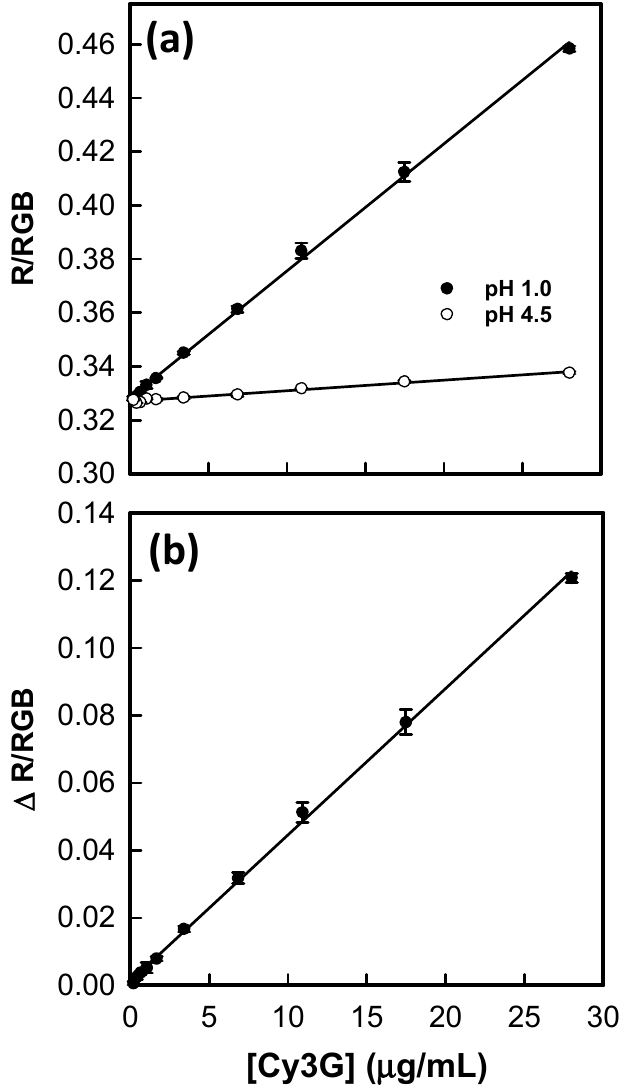
Figure 5. ( a ) R/RGB value at different concentrations of Cy3G at pH 1.0 (solid circles) and pH 4.5 (open circles). ( b ) ∆ (R/RGB) (difference between the values at pH 1.0 and pH 4.5) vs. the Cy3G concentration, where the solid line shows the best linear fit to the experimental data.